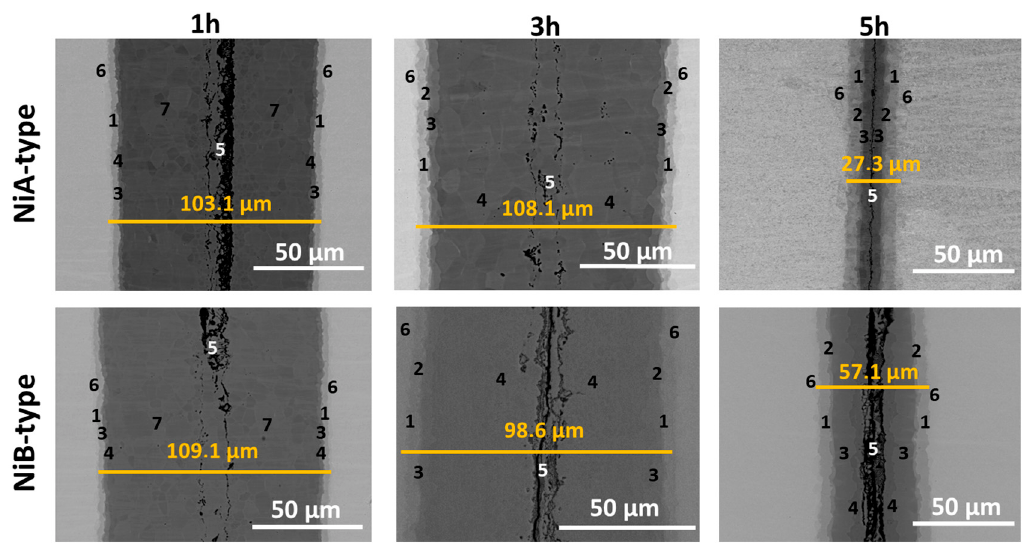
Figure 5. Microstructure of the Ni/Al/Ni couples obtained at 720 °C after annealing for: 1, 3, 5 h using A- and B- type of Ni substrates. Numbers 1–6 denote particular intermetallic phases: 1-AlNi 3 , 2-AlNi Ni-rich , 3-AlNi, 4-AlNi Ni-deficient , 5-(Al) + Al 3 Ni, 6-Ni solid solution, 7-Al 3 Ni 2